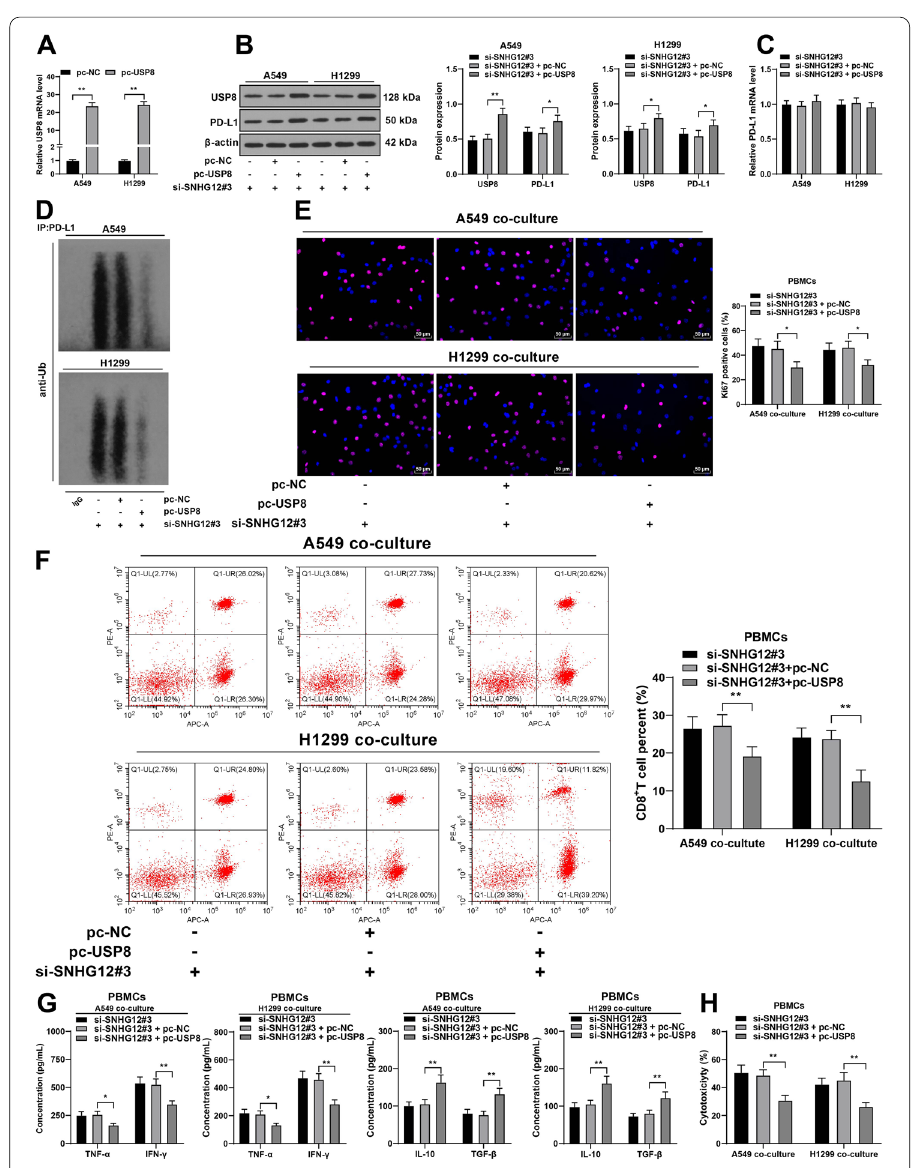
Fig. 7 USP8 overexpression attenuated the inhibition of silencing lncRNA SNHG12 on the immune escape of NSCLC. A549 or H1299 cells were transfected with USP8 pcDNA3.1 (pc-USP8), with NC pcDNA3.1 (pc-NC) as the negative control. A mRNA level of USP8 in NSCLC cells was measured via RT-qPCR; B protein expression of USP8 and PD-L1 was detected via western blotting; C mRNA level of PD-L1 was measured via RT-qPCR; D ubiquitination level of PD-L1 in NSCLCs was determined via western blotting; A549 or H1299 cells in different treatment groups were co-cultured with isolated PBMCs. E PBMC proliferation was observed via Ki67 staining; F percentage of CD8 + T cells in PBMCs was determined via flow cytometry; G concentrations of TNF-α, IFN-γ, IL-10, and TGF-β were determined via ELISA; H cytotoxicity of PBMCs was detected via LDH cytotoxicity assay. Cell experiments were performed three times, * P < 0.05, ** P < 0.01. Data are represented as mean deviation. Multigroup comparisons in A – C and E – H were analyzed using two-way ANOVA, followed by Tukey’s multiple comparison